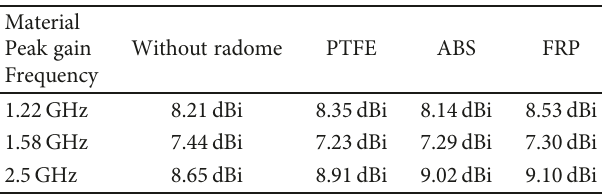
Table 2: Peak gain of di ff erent materials of radomes at selected